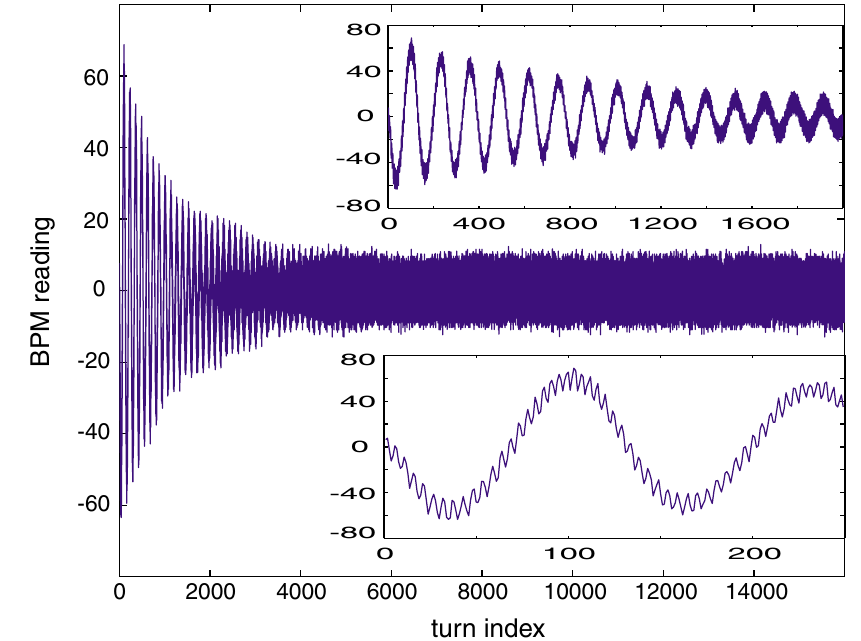
FIG. 4. (Color) Beam history at one BPM. The upper insert is the first 2000 turns showing synchrotron oscillation due to a longitudinal phase kick. The lower insert is the first 250 turns showing a betatron oscillation (due to instability) superimposed on the synchrotron